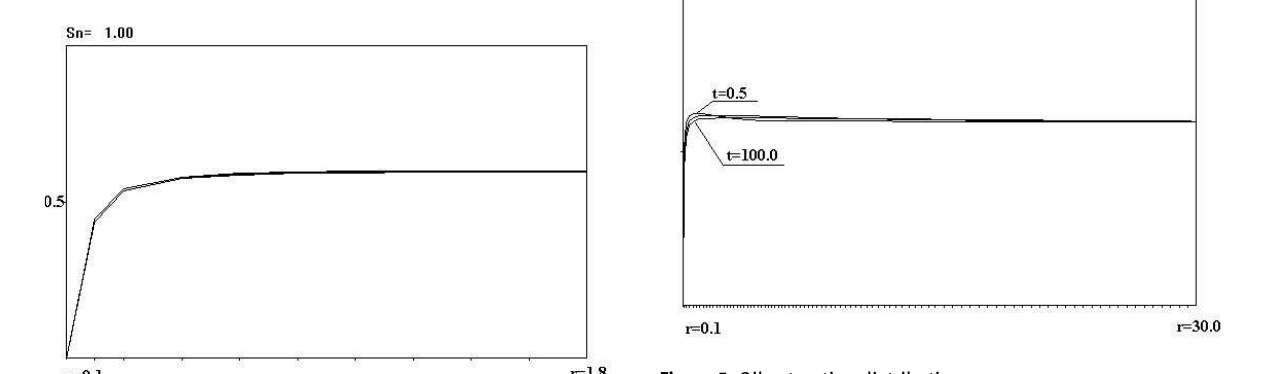
Figure 5: Oil saturation